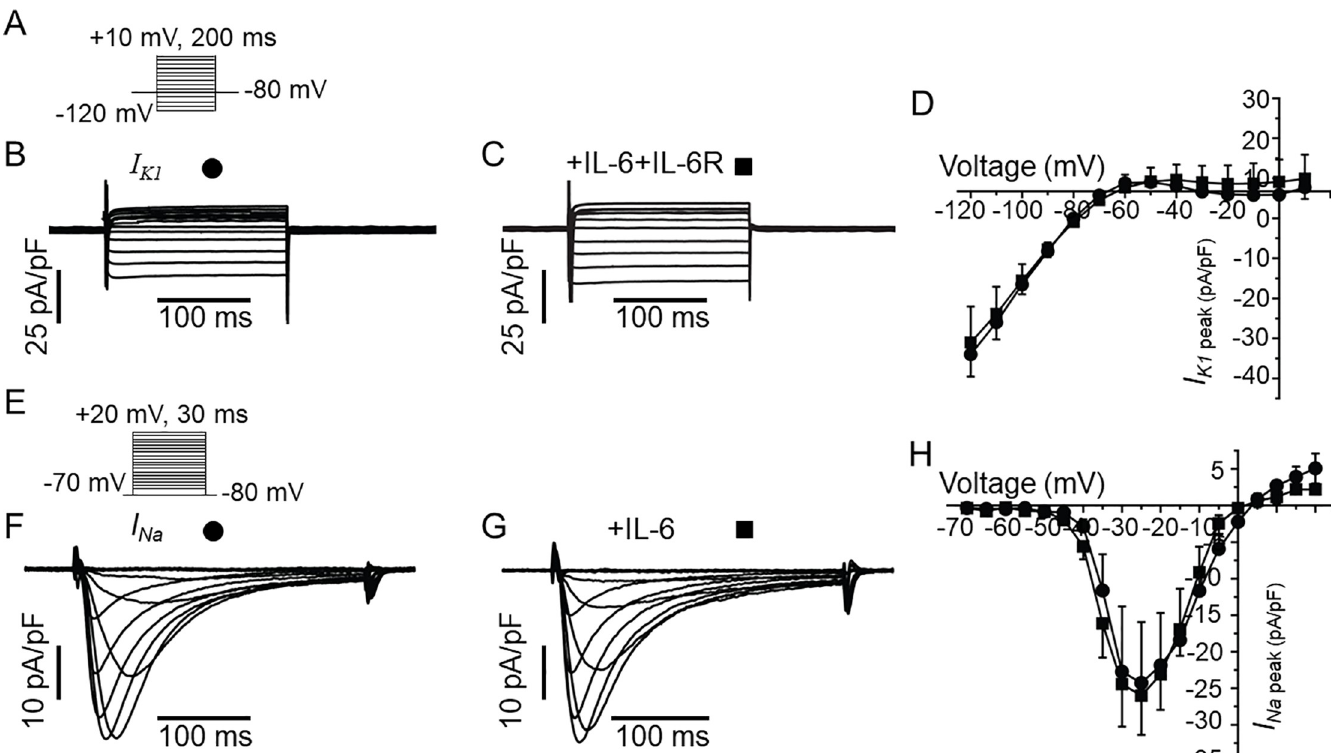
Fig 7. IL-6 has no effect on I K1 or I Na in guinea-pig ventricular myocytes. A , Voltage protocol for activation of I K1 . Representative I K1 traces for a control myocyte ( B ) and from an IL-6+IL-6R pre-treated myocyte ( C ). D , Population I (square, n = 4) compared to untreated myocytes (circle, n = 3) at all voltages between -120 mV to +10 mV. E , The voltage protocol for evoking I showing that I Na measured in control cardiomyocytes ( F ) are identical to I Na recorded in myocytes pre-treated with IL-6 alone ( G ). H , pooled data for I Na peak-voltage in untreated (circle, n = 6), and IL-6-treated myocytes (square, n = 6).